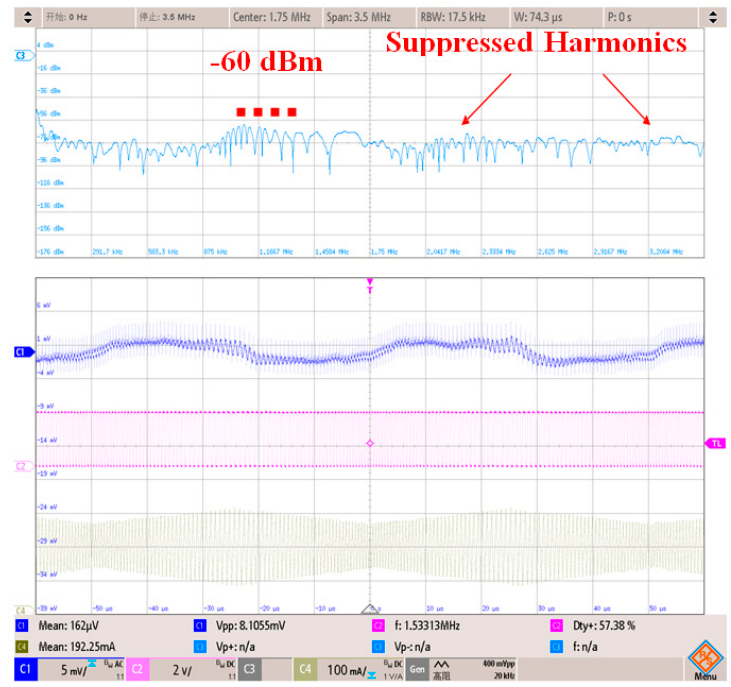
Figure 18. Measured spectrum waveform with the proposed triangular spread-spectrum mechanism.